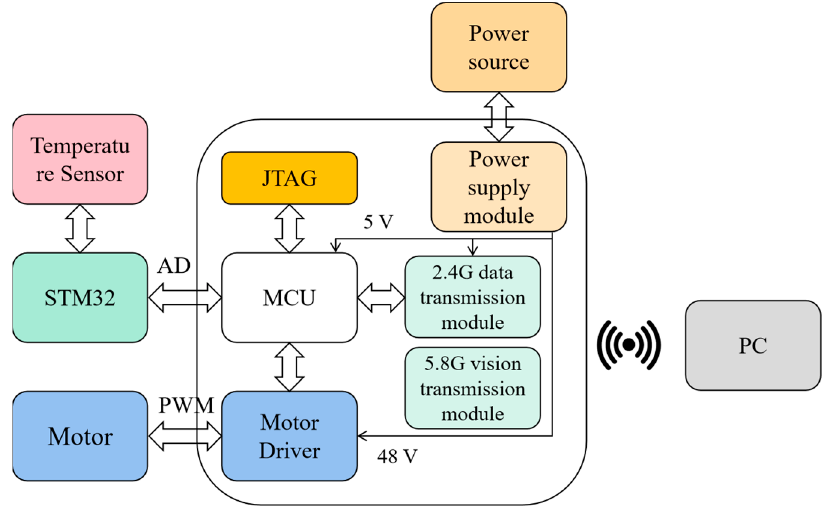
Figure 8. Electrical system design of robot.